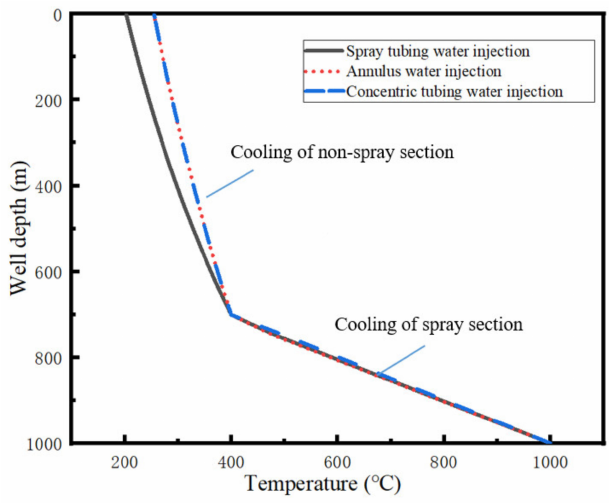
Figure 11. Distribution of produced gas temperature field after wellbore